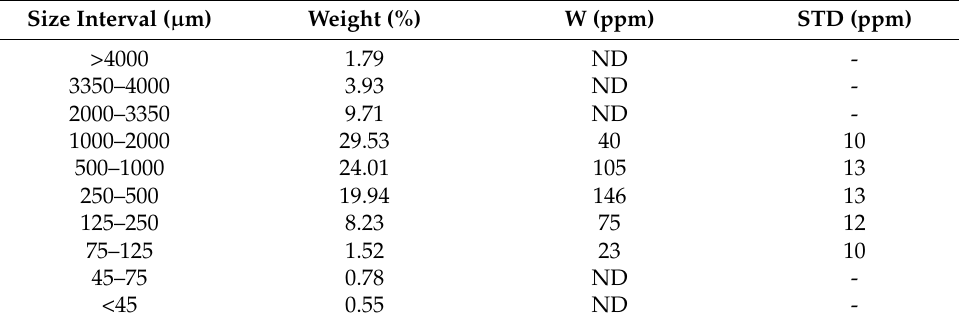
Table 2. Fractional results of XRF (ND = not